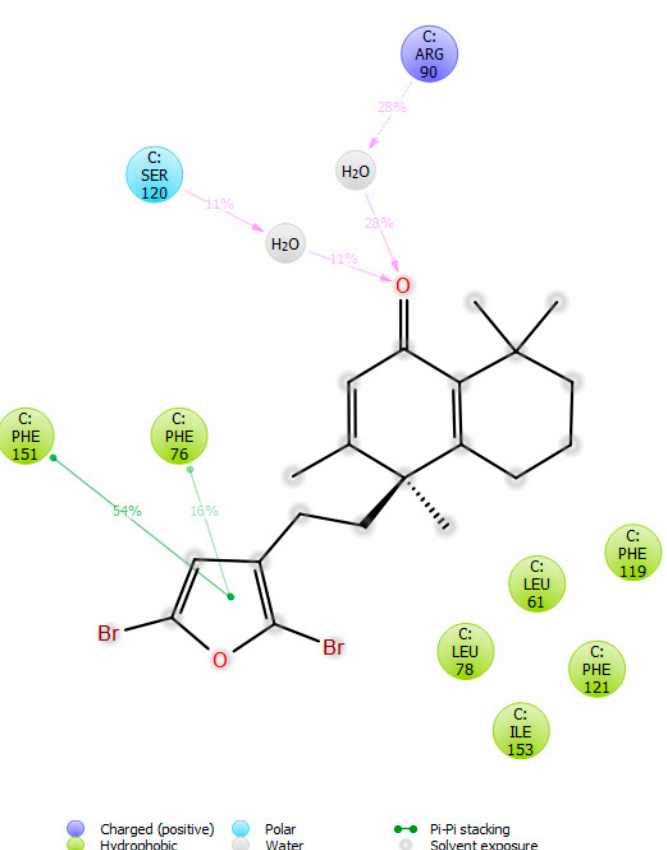
Figure 11. Interactions of compound 5 with the key amino acid residues at the hydrophobic binding pocket of MD-2 (docking score: − 8.51 kcal mol − 1 ). The colors indicate the residue type: green are lipophilic residues; blue are polar residues; purple are basic residues. Ligand atoms that are exposed to the solvent are marked with grey spheres. C: means MD2 region of TLR4.